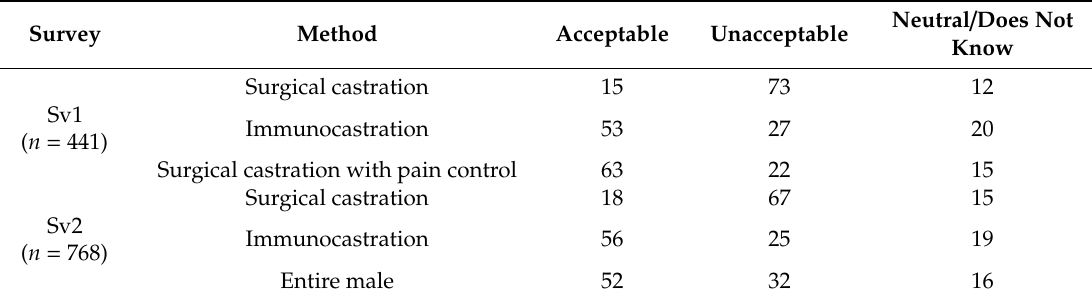
Table 1. Descriptive data on acceptability (%) of the different methods to deal with boar taint in pig meat.